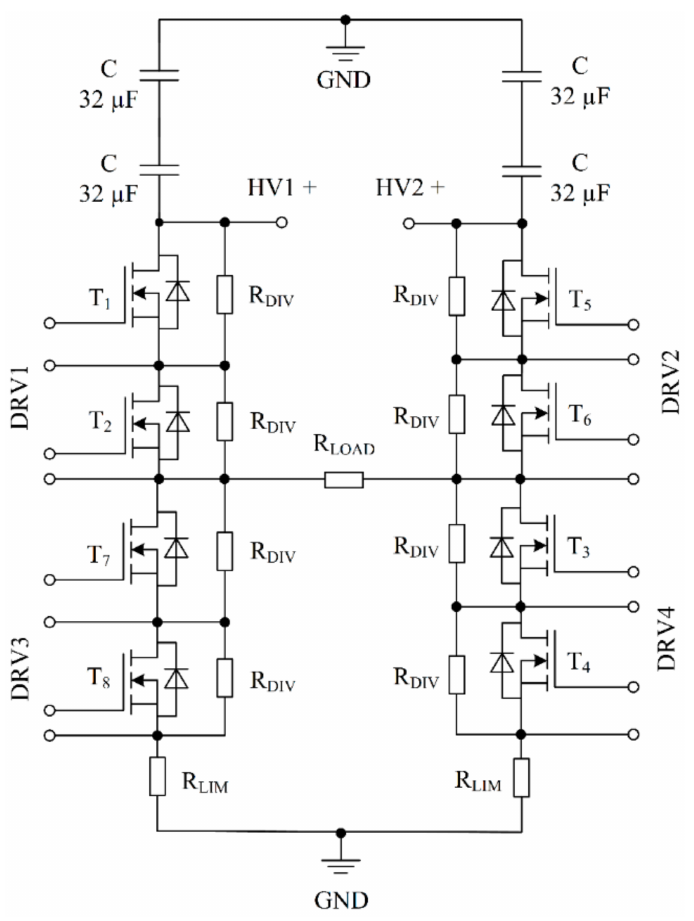
Figure 1. The pulse forming circuit of the electroporator, which is based on H-bridge circuit topology. As high voltage sources, two UM4P30 (Spellman High Voltage Electronics Corp., Hauppauge, NY, USA) voltage supplies were used. The R DIV = 1 M Ω were used as bleeder resistors to equally distribute the DC voltage. The capacitor array included two capacitors in each stage (32 µ F, KEMET MKP C4AQ, Fort Lauderdale, FL,